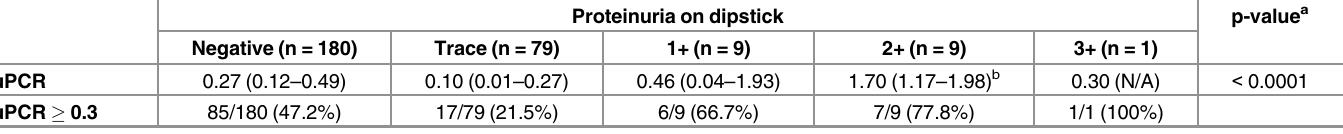
Table 3. Urinary protein/creatinine ratio (uPCR) by urine dipstick protein result.